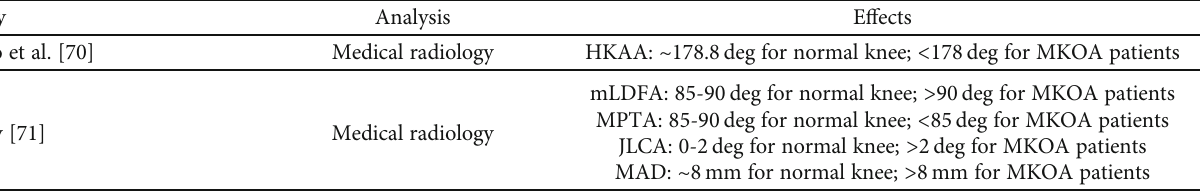
Table 12: Overview over the biomechanical e ff ects of